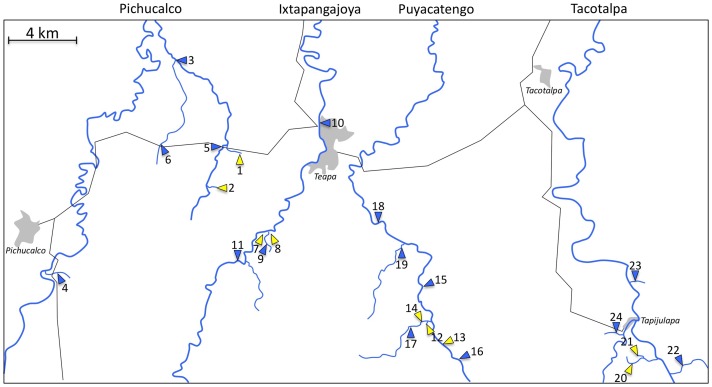
Overview of the study area and sampling localities of three Poecilia species in southern Mexico.Sampling of P. thermalis, Poecilia mexicana mexicana, and P. sulphuraria in southern Mexico. The colors represent sulfidic (yellow) and non-sulfidic (blue) sites and the numbers represent localities as described in Table 2 of the main manuscript. For orientation purposes, we included black lines representing major roads and gray areas representing major towns in the region.